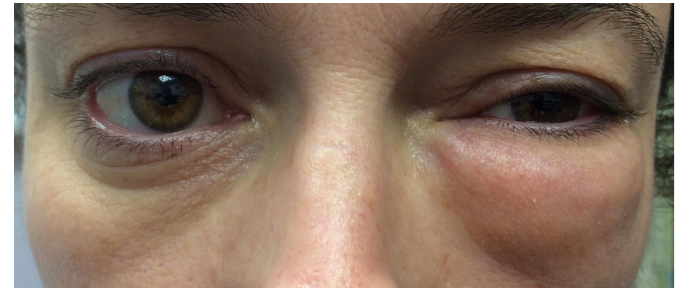
Image 1. Non-tender left periorbital swelling.